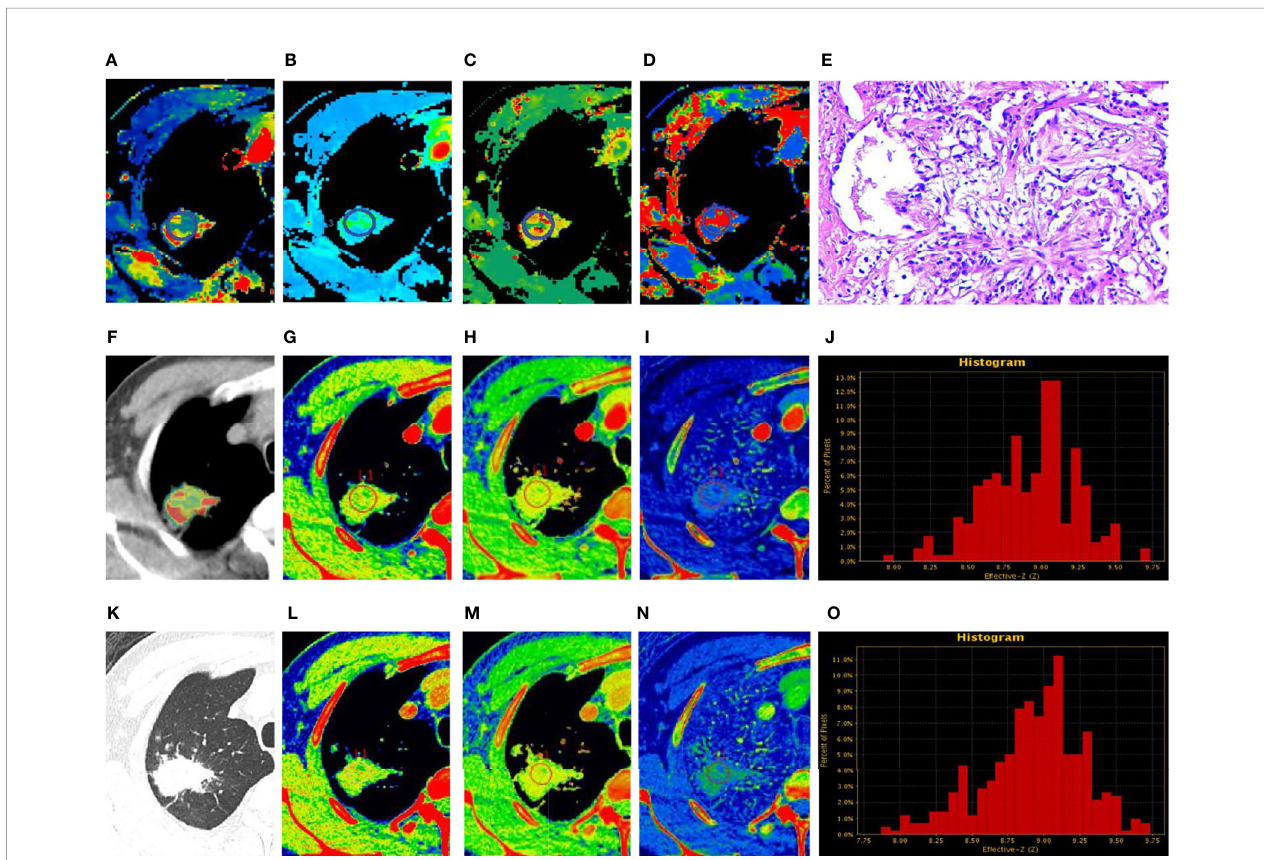
FIGURE 2 | Focal organizing pneumonia. (A – D, F) Perfusion computed tomography (CT) fusion pseudo-color map; (E) Hematoxylin and eosin staining (original magni fi cation ×200); (G – J) Spectral CT images of arterial phase (AP); (K) Lung window; (L – O) Spectral CT images of venous phase (VP). (A – D) Blood fl ow, blood volume, permeability surface, and average transit time values of the lesions were 63.74 mL/100 g·min, 10.29 mL/100 g, 25.06 mL/100 g·min, 16.09 s, respectively. (G, L) 70 keV single-energy pseudocolor image (CT number of 70 keV were 79.27 HU and 75.9 HU, respectively). (H, M) The effective atomic numbers (Zeff)